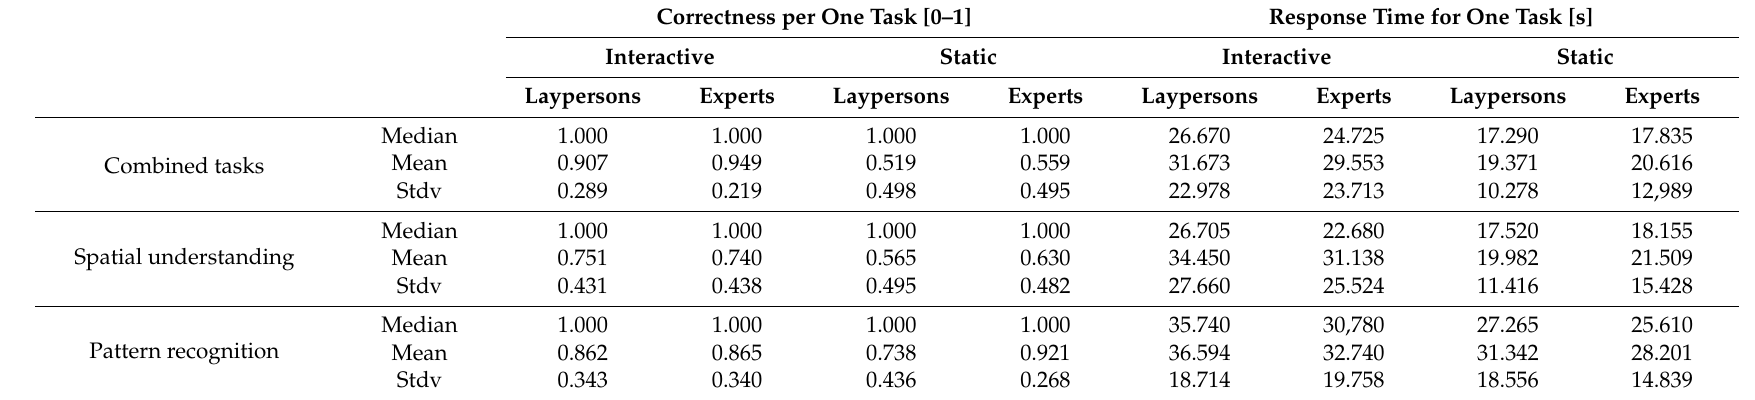
Table 3. Correctness of user responses and time demands in individual tasks according to level of interactivity, level of expertise, and task type. Correctness per One Task [0–1]